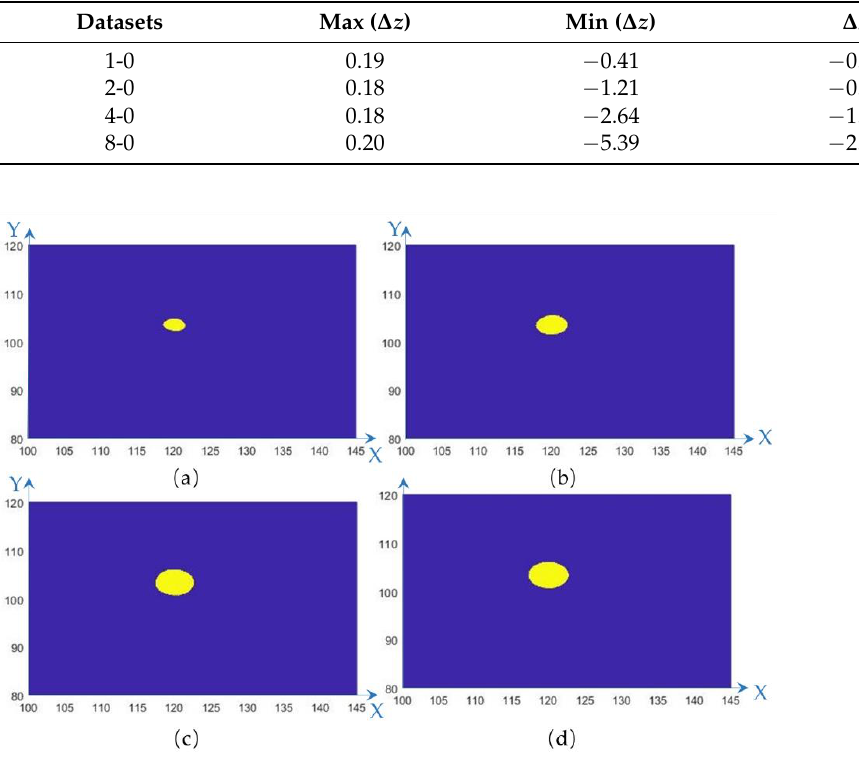
Figure 10. Results of subsidence detection (m): ( a ) 1 cm; ( b ) 2 cm; ( c ) 4 cm; ( d ) 8